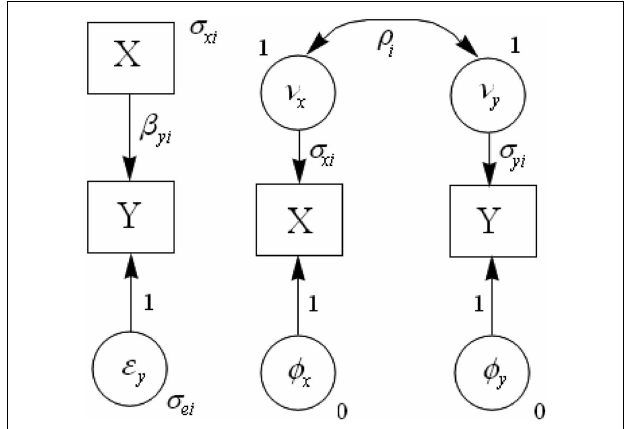
FIGURE 2 | Moderated regression and correlation structural equations models.